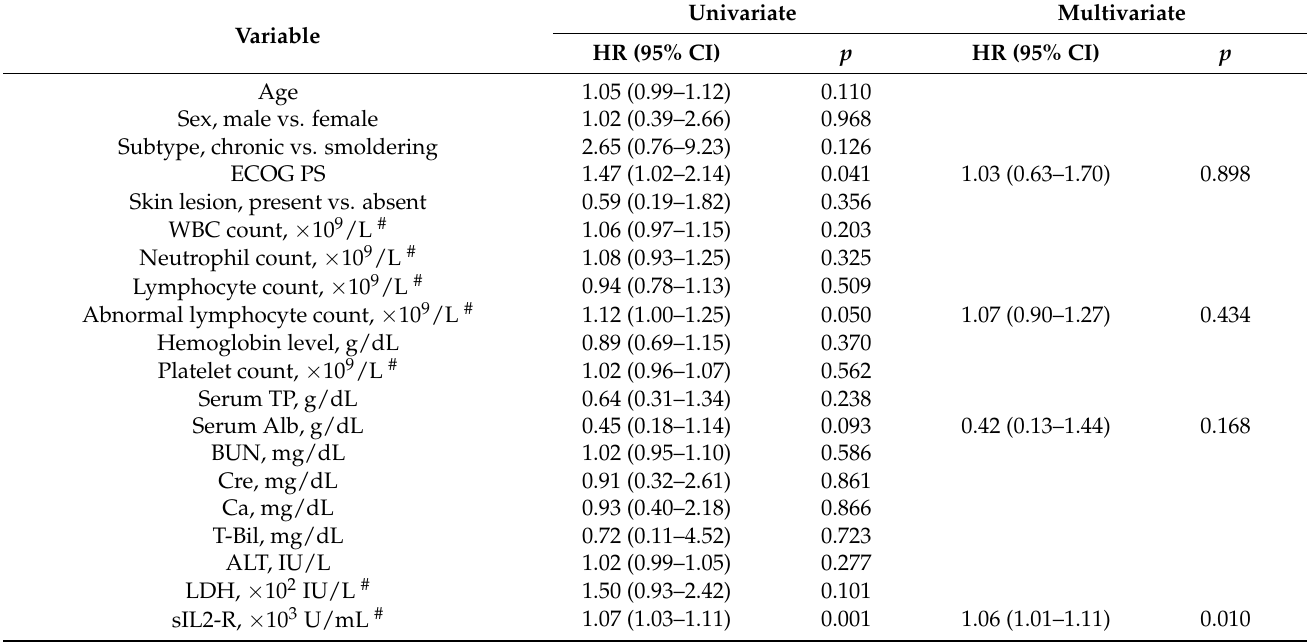
Table 3. Univariate and multivariate Cox regression analyses of overall survival ( n =